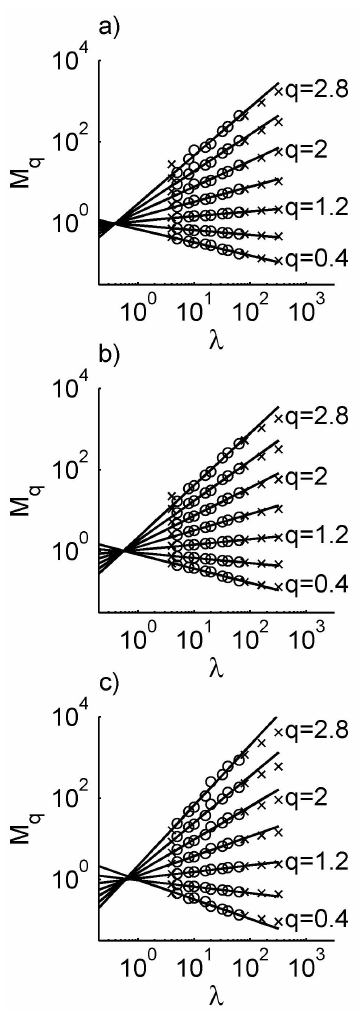
Fig. 7. Relationship between M q and λ for different values of q . M q is computed from q c at z q at 04:00h for simulation (a) Sst5km, c max (b) Sst10km and (c) Sst15km. The scales considered on the analysis are marked by “o” while “x” marks the ones not considered. The plots are on a log–log scale.